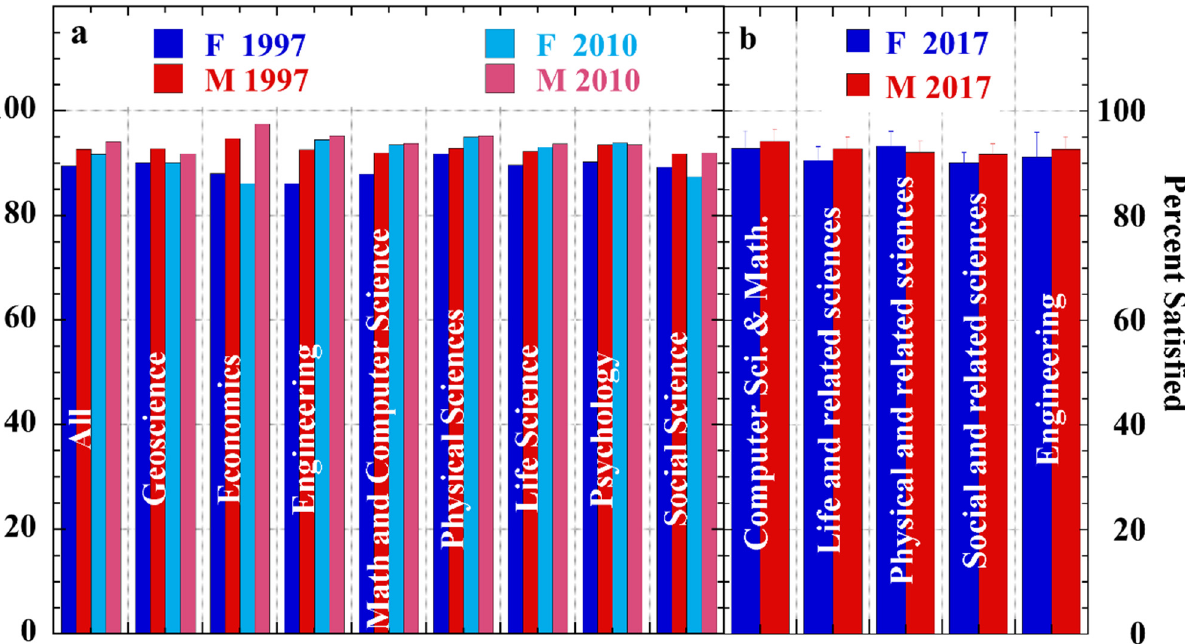
Figure 1. Percentages of female and male faculty reporting themselves somewhat satisfied or very satisfied with their jobs. Panel ( a ) is 1997 and 2010 data for selected academic fields, extracted from Figure 19 of [21]. Panel ( b ) is 2017 data for post-secondary STEM and includes combined social science and psychology faculty (National Center for Science and Engineering Statistics (NCSES). The uncertainty whiskers in panel ( b ) are ±1 σ standard error. See the Acknowledgements and the Supplemental Information for panel ( b )’s source and data.